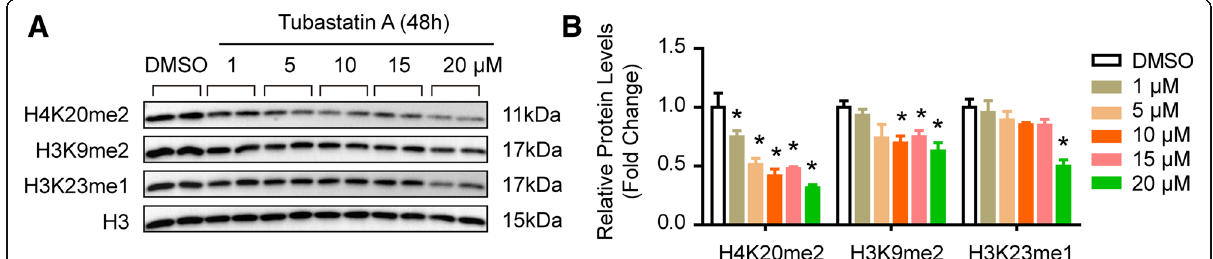
Fig. 4 Histone methylation regulated by HDAC6. a and b The protein levels of H4K20me2, H3K9me2, and H3K23me1 were detected by western blot in primary cultured HAVSMCs treated with DMSO or different concentrations of tubastatin A ( n = 4 samples per group), * p < 0.05 vs.